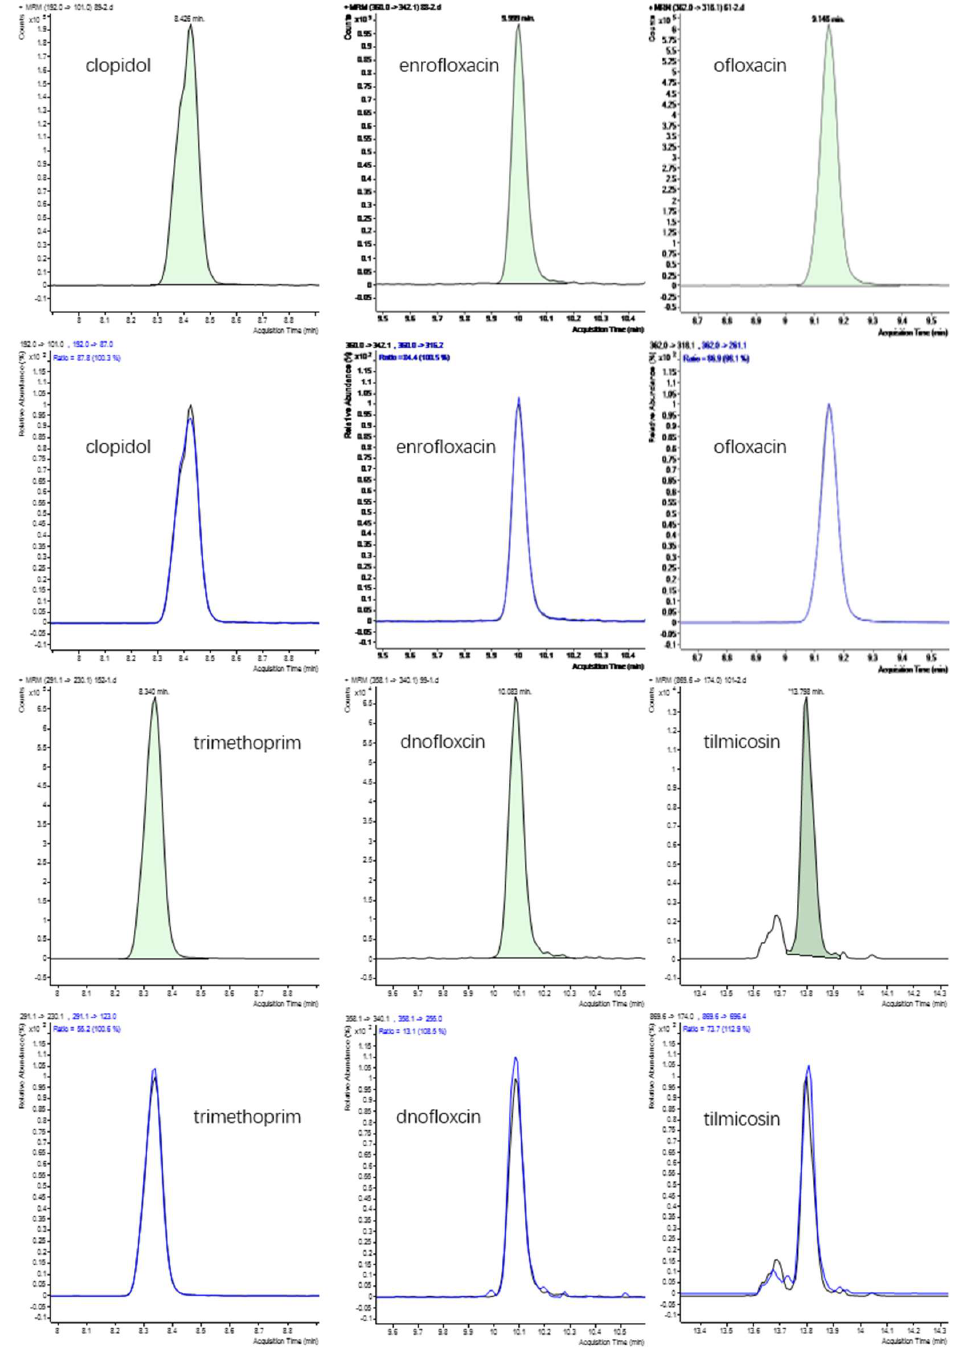
Figure 6. The ion chromatograms of the compounds detected in the actual sample.